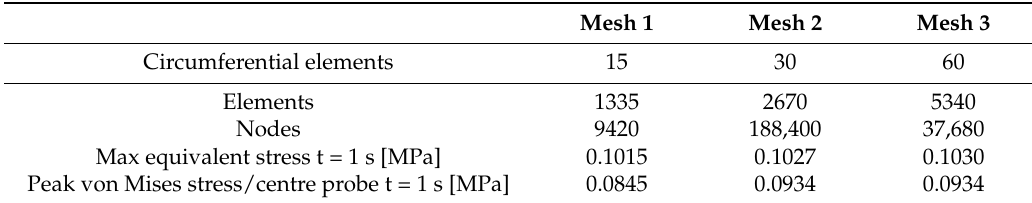
Table 1. Maximum equivalent stress and peak von Mises stress of the centre probe at t = 1 s [MPa] on the aortic model during evaluation of critical compression